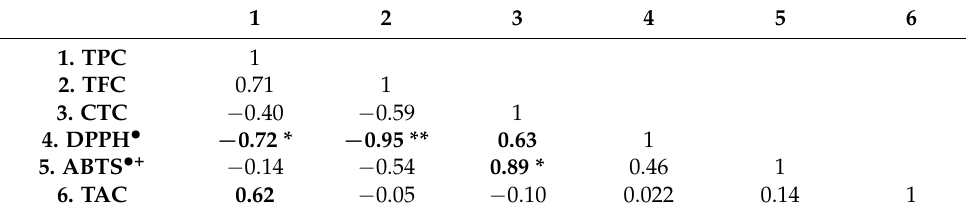
Table 7. Correlation matrix between phenolics contents and antioxidant activity of pomegranate varieties